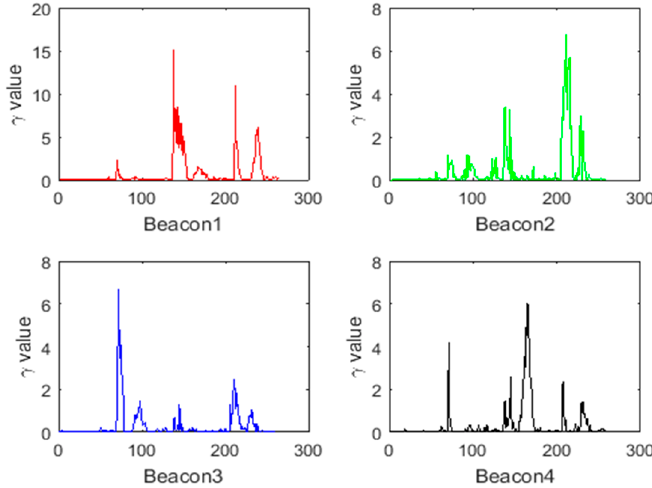
Figure 12. The values of γ k for the four beacons computed along Route